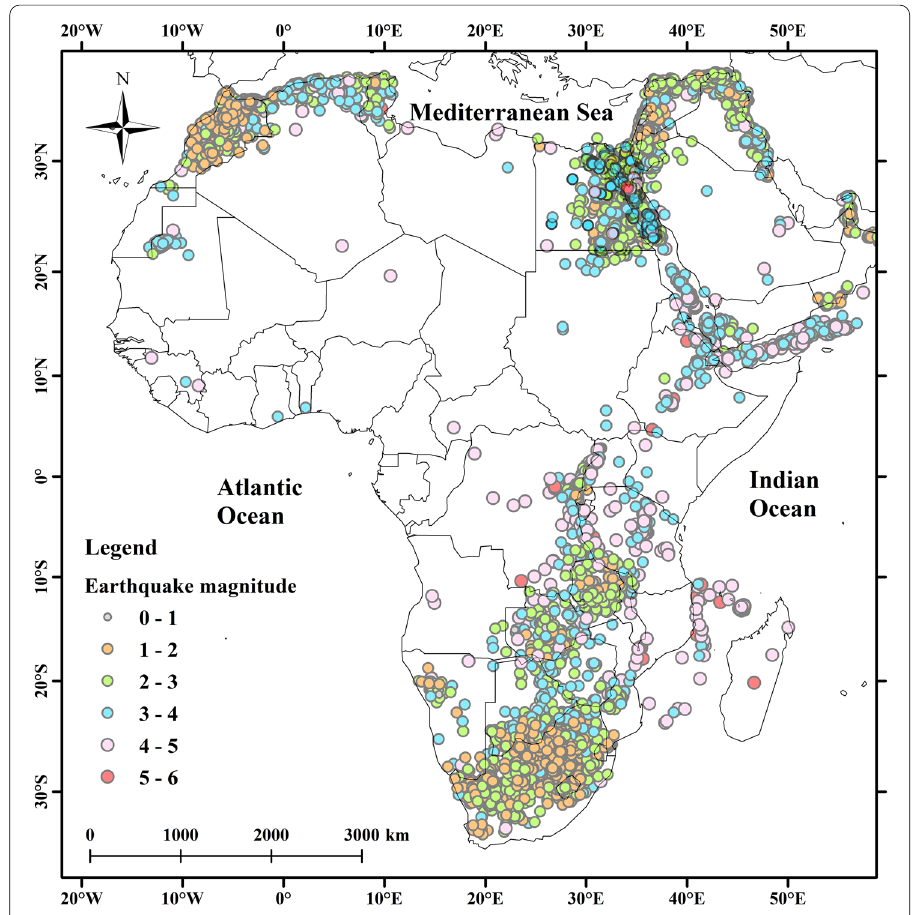
Fig. 4 Distribution of earthquake epicenters in Africa that have depths less than 10 km with magnitudes from 1 to 6, during the period from 2000 to 2018. Data collected from the International Seismological Center, the USGS, and the Egyptian Seismological